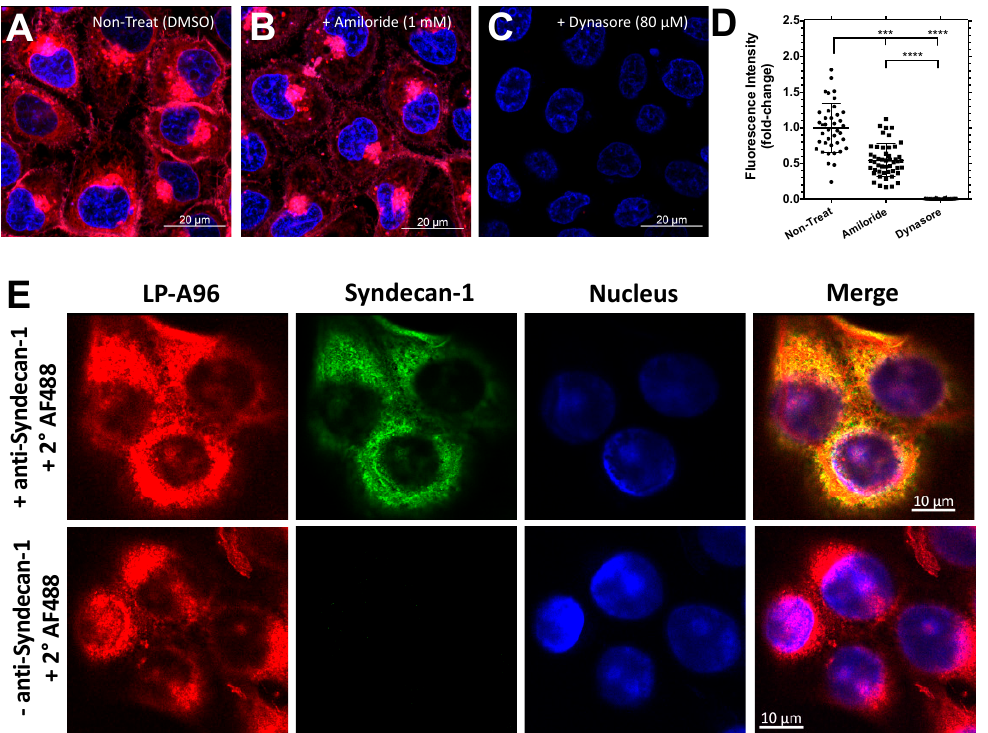
Figure 6. LP-A96 is internalized via dynamin-dependent endocytosis and colocalized with syndecan-1 in corneal epithelial cells. ( A – D ) HCE-T cells were treated with either DMSO (vehicle control), amiloride (1 mM), or dynasore (80 μ M) prior to addition of 1 μ M rhodamine-labeled LP-A96. ( D ) Quantified fluorescence intensity per cell under each treatment. n = 39 for DMSO, n = 49 for amiloride, n = 48 for dynasore. Representative images are shown from the three independent experiments. ( E ) LP-A96 was colocalized with syndecan-1 in HCE-T cells. (Pearson’s correlation = 0.8, n = 32). 1 μ M rhodamine-labeled LP-A96 were incubated with the cells for 15 min at 37 °C prior to fixation. Secondary immunofluorescence revealed apparent colocalization of rhodamine-labeled LP-A96 and Syndecan-1. Anti-syndecan-1 antibody was further detected by Alexa Fluor 488 conjugated secondary antibody. Nuclei were stained with DAPI (4 ′ ,6-diamidino-2-phenylindole). A one-way ANOVA followed by multiple comparisons was used for statistical comparison. **** p < 0.0001, *** p < 0.001. Mean ± SD.